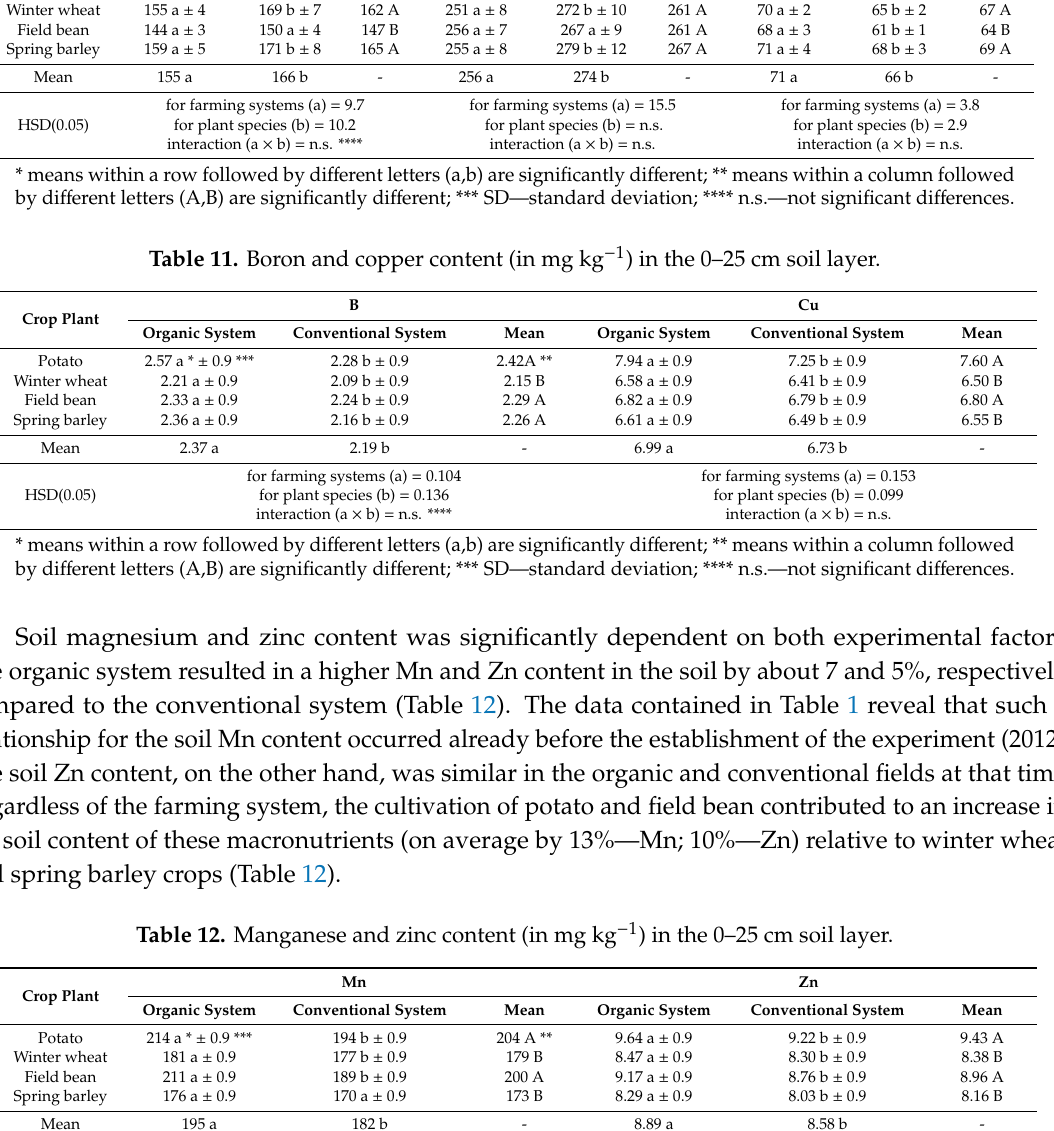
Table 10. Soil macronutrient content (in mg kg − 1 soil) in the 0–25 cm soil layer. P K Mg Crop Plant Organic Conv. System System Mean Potato 161 a * ± 6 *** 175 b ± 9 168 A **